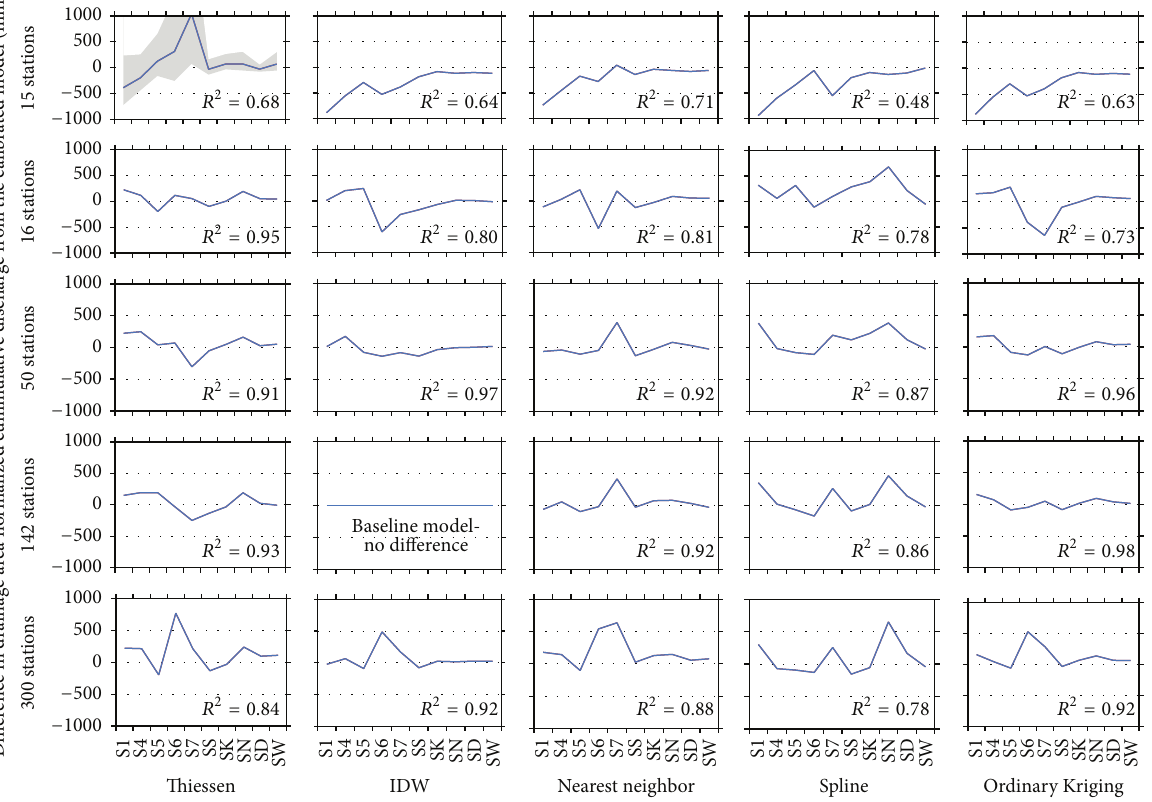
Figure 7: Comparison of the difference in normalized surface water discharge for each monitoring location between interpolation methods and meteorological station density. The coefficient of determination ( 𝑅 2 ) is a comparison between the individual simulation and the baseline model. The range in discharge shown in the Thiessen polygon panel for 15 stations assumes a single lumped precipitation value based on the minimum and maximum observed